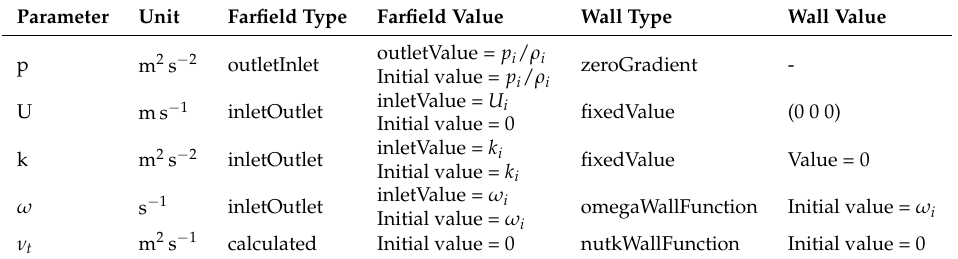
Table 3. Initial and boundary conditions definition, adapted from [20].